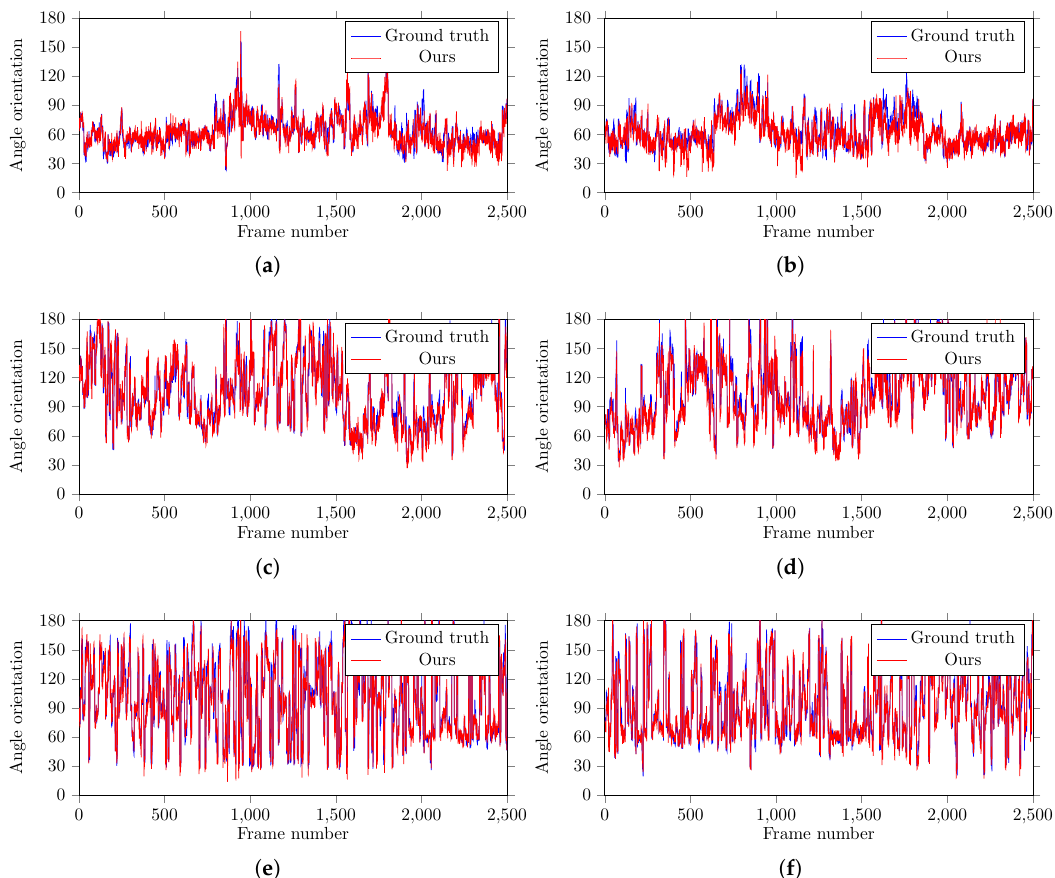
Figure 9. Predicted and the ground-truth angle orientations of ( a ) right shoulder, ( b ) left shoulder, ( c ) right elbow, ( d ) left elbow, ( e ) right knee, and ( f ) left knee in a test video sequence with 2500